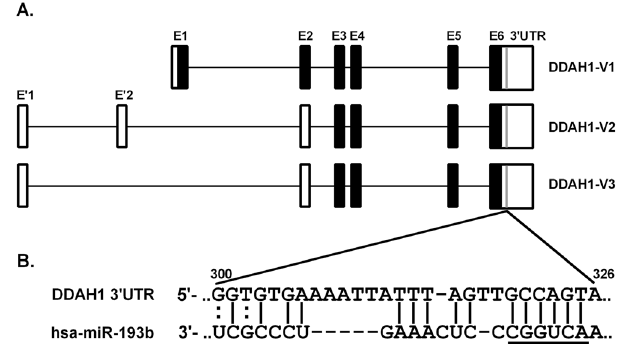
Figure 1. The 3 ′ UTR of DDAH1 mRNA contains a putative miR-193b binding site. ( A ) Gene structure and the 3 transcript variants of human DDAH1 . Black boxes represent the open reading frame (ORF) and empty boxes represent the untranslated regions (UTRs). DDAH1-V2 and -V3 encode for a N-terminally truncated protein compared to DDAH1-V1 . All 3 variants have the same 3 ′ UTR. Grey lines represent the location of the putative miR-193b binding site. ( B ) Schematic of predicted binding of miR-193b at positions 300–326 of DDAH1 3 ′ UTR. Numbering is relative to the stop codon (TGA with A positioned as − 1). Underline indicates seed sequence of miR-193b. | indicates complementary base pairing and : indicates a weak binding